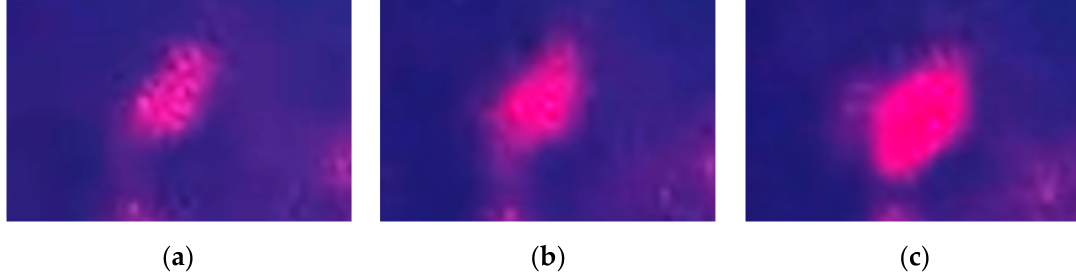
Figure 8. Far-field images of ( a ) higher-order diffracted light beam spot from the OPA during unactuated state; ( b ) the diffracted light with an increased intensity on the same spot during transition to actuated state; ( c ) the diffracted light with maximum intensity on the same spot due to the actuation.